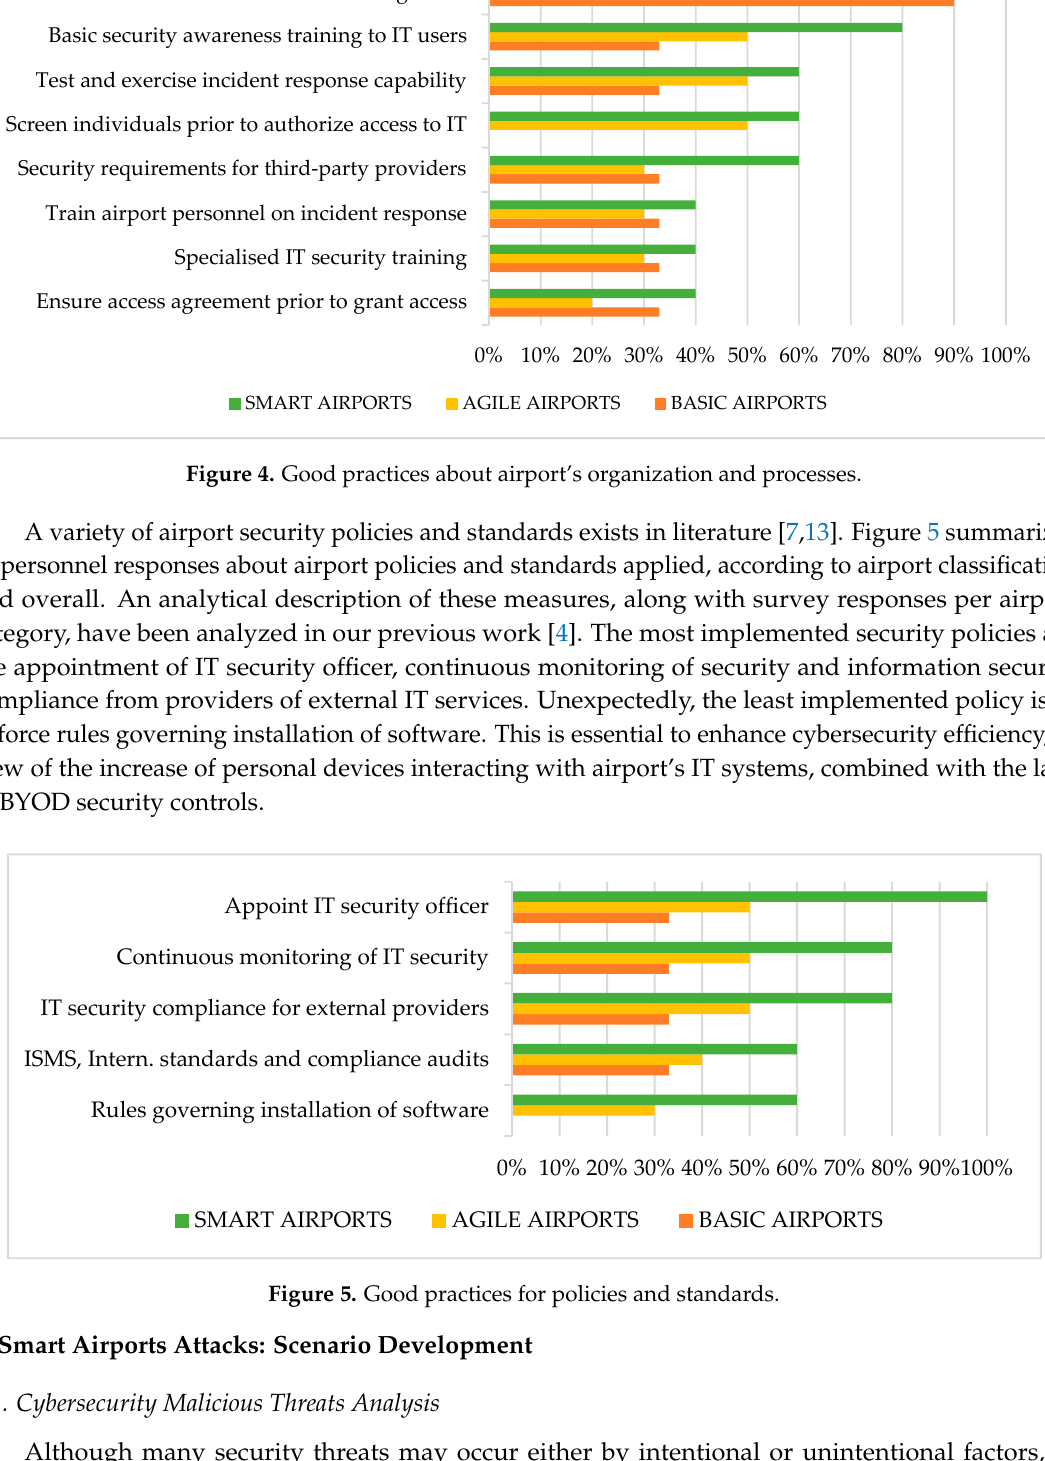
Figure 6. Cybersecurity malicious threats categories. 1)